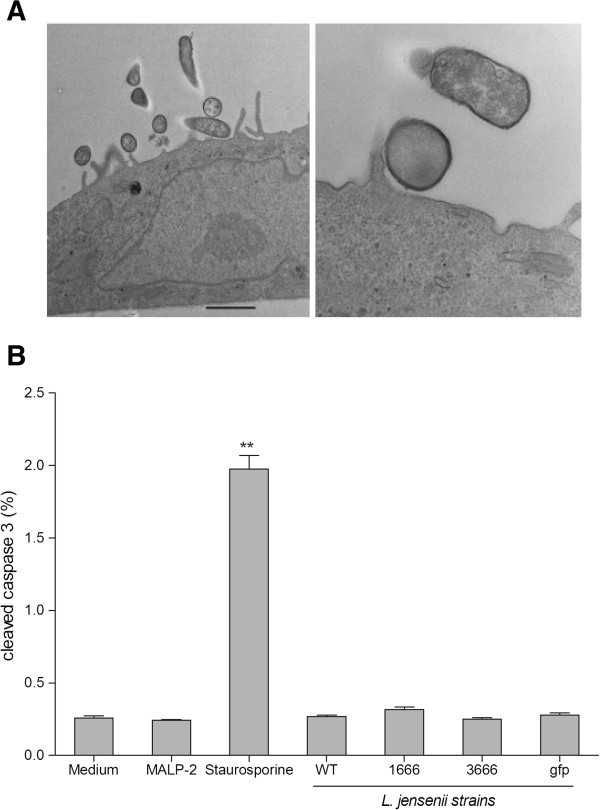
Lactobacillus strains consistently associate with the human epithelial model in the absence of apoptosis. (Figure 1a) Transmission electron microscopic image illustrates clear association between the L. jensenii electron dense bodies and the morphologically intact vaginal epithelial cells. No morphological signs of apoptosis are present. Bar represents 2 microns with a magnification of x 4800. (Figure 1b) Caspase-3 cleavage represented by % cleaved over total caspase harvested from vaginal (Vk2/E6E7) epithelial lysates after 24 h colonization with L. jensenii 1153 wild type (WT) and bioengineered L. jensenii 1153–1666, 3666 and gfp strains or treatment with 1 μM Staurosporine positive control. Bars display means and SEM from triplicate cultures in one of three experiments. ** P<0.01 different from medium control.